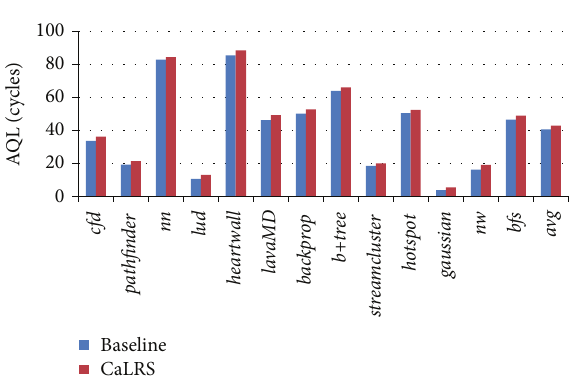
Figure 8: Average queue length comparison of baseline and CaLRS. Figure 9: The average queue latency changement for different classes of memory requests that have the same